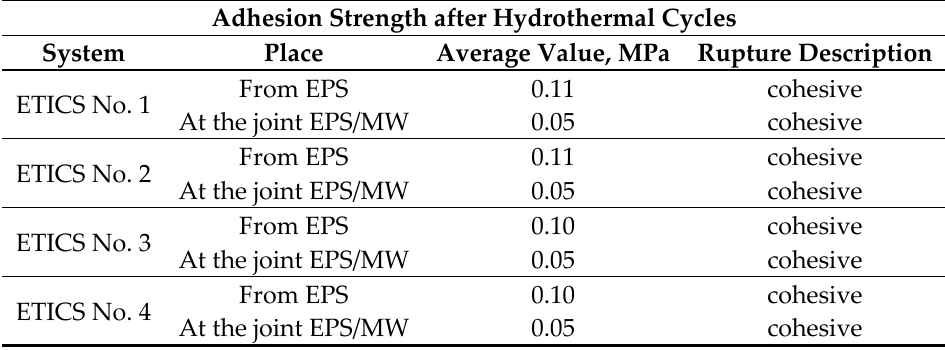
Figure 3. Temperature variation in ETICS fragment layers during hydrothermal cycles: 4–4 temperature in the middle of mineral wool, 4–5 temperature at the junction of mineral wool and polystyrene foam, 4–6 temperature in the middle of polystyrene foam. T-pav. —temperature on the rendering. Table 1. Results of adhesion strength tests of mineral wool, EPS and joints between EPS and MW with base layer after hydrothermal cycles (touch-drying,